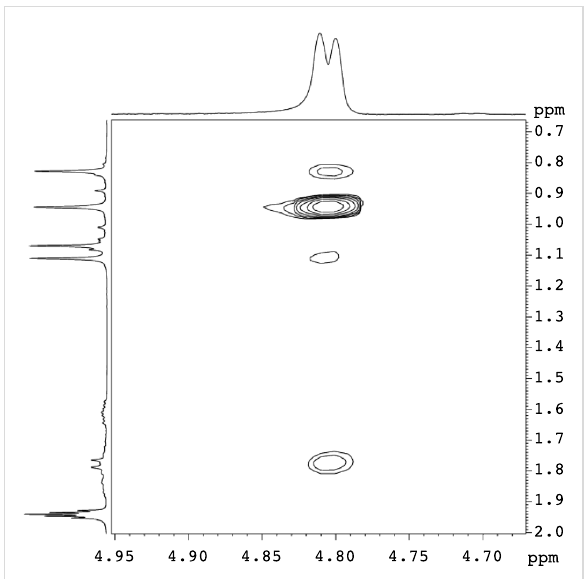
Figure 6: NOESY spectrum (detail) showing the cross peak between H3A and H10A (see Supporting Information File 1, Figure S6 for the full